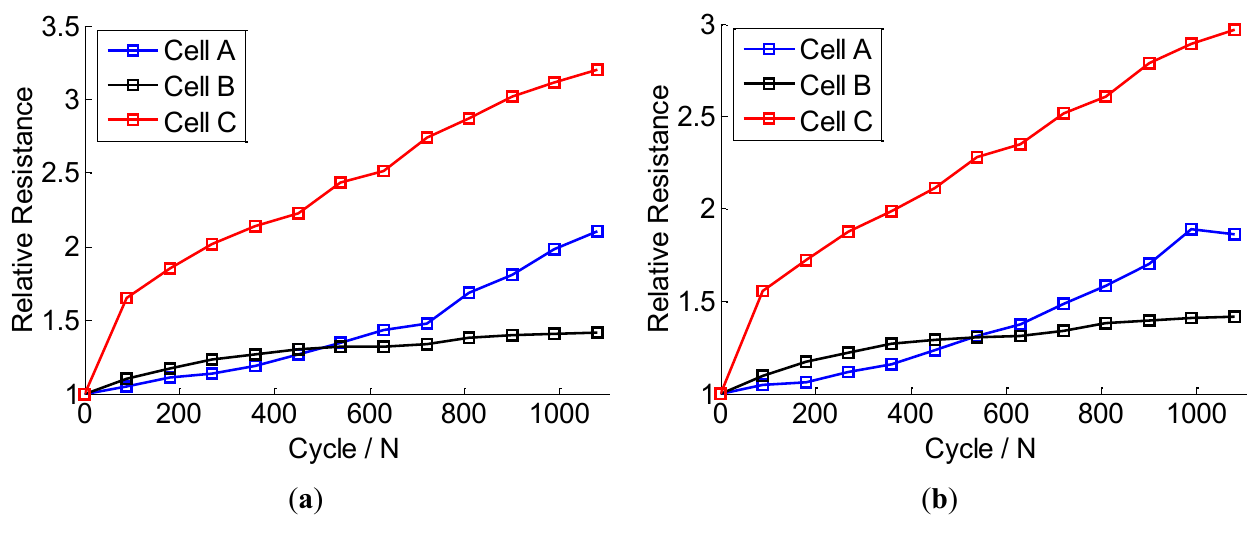
Figure 3. The resistance evolution of the three cells: ( a ) 10 s discharge resistance at 50% SOC; and ( b ) 10 s charge resistance at 50%